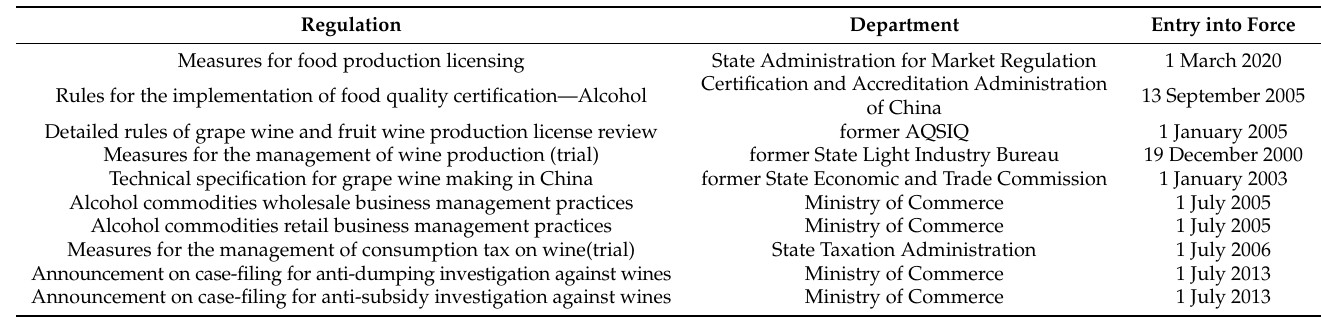
Table 9. Some regulations on wine production management and market